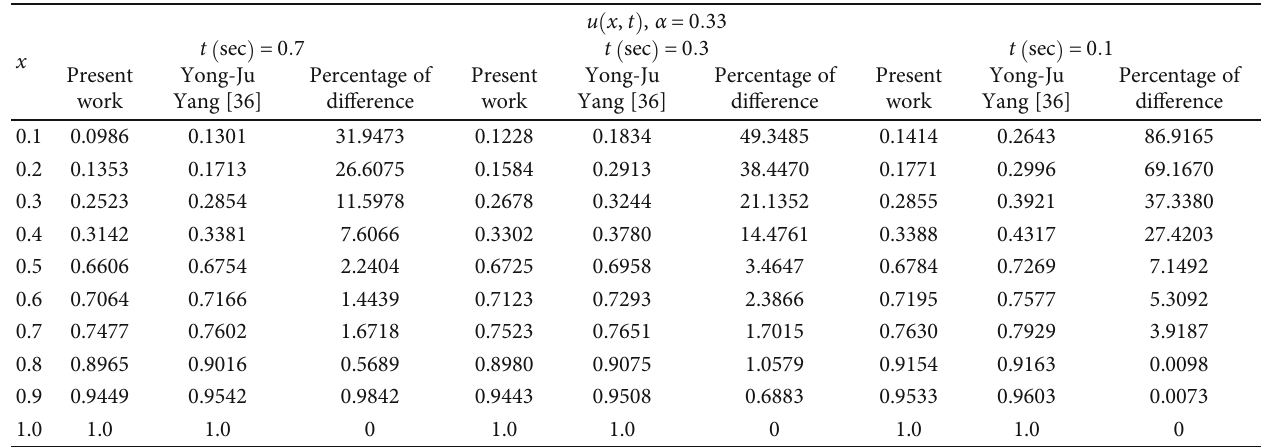
Table 2: The variation of u ð x , t Þ versus x with α = 0 : 33 , t = 0 : 1, 0 : 3, and0 : 7 sec